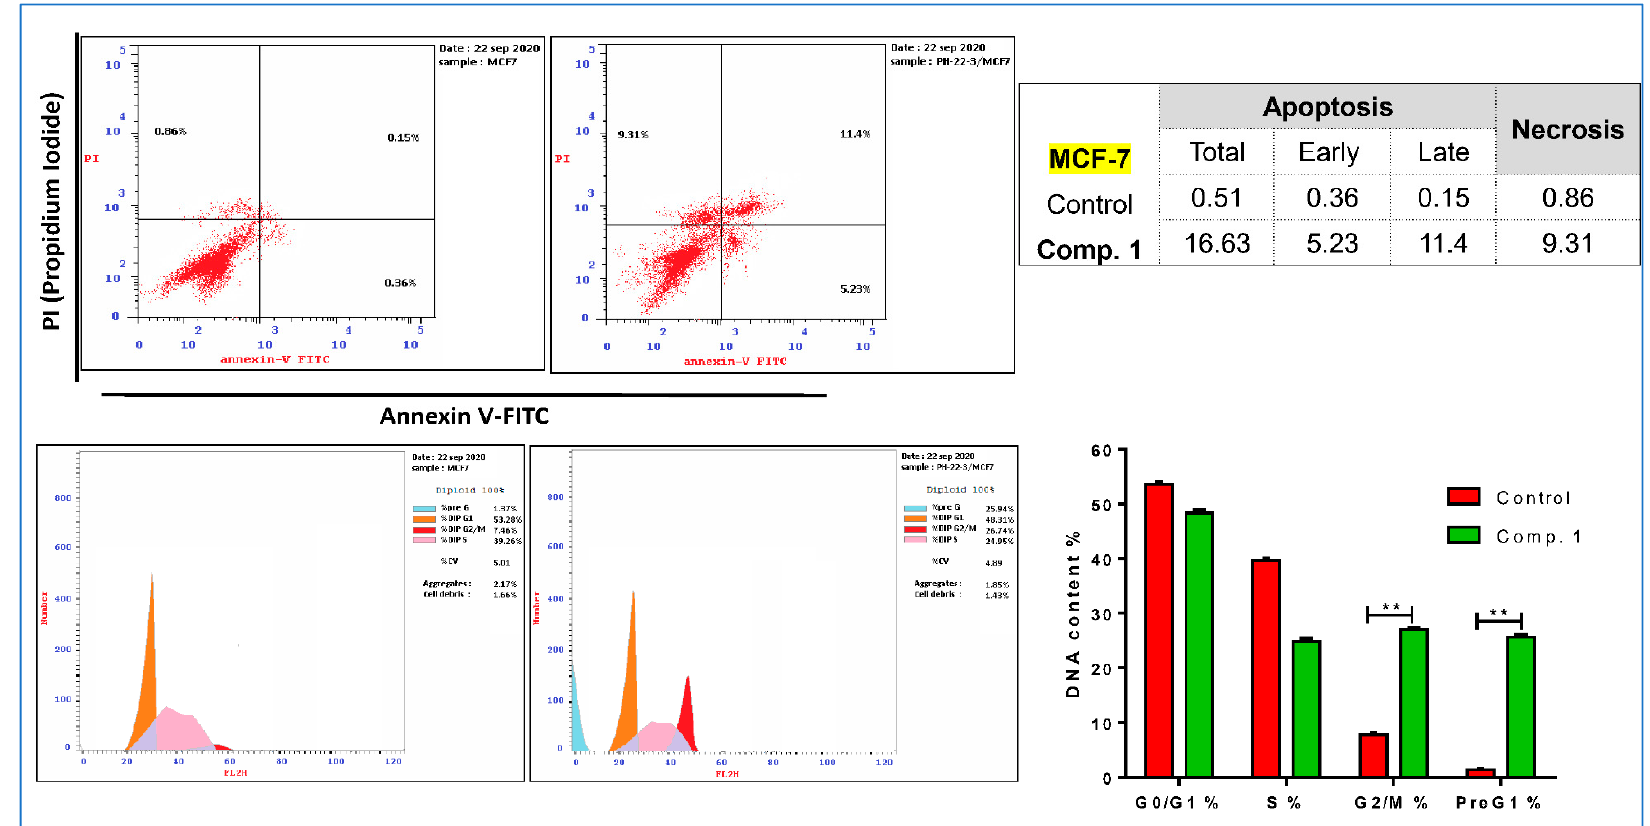
Figure 5. FITC/Annexin-V-FITC/PI differential apoptosis/necrosis (Upper panel) and DNA content flow cytometry-aided cell cycle analyses with bar chart representation (Lower panel) of both untreated and treated MCF-7 treated with compound 1 (IC 50 = 25.92 µM, 48 h). ** p < 0.05 compared to the control.